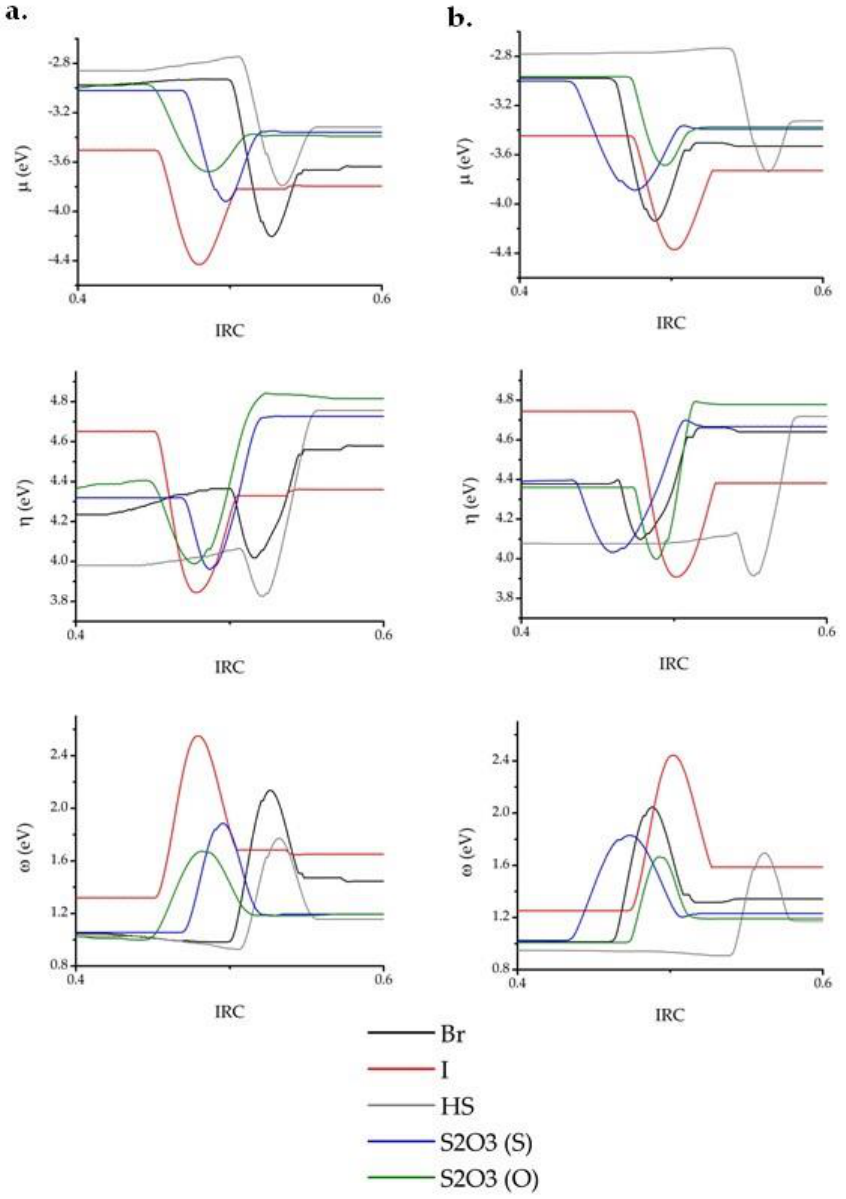
Figure 5. µ, η, and ω zoomed plots for the nucleophilic substitution of alachlor ( a ) and propachlor ( b